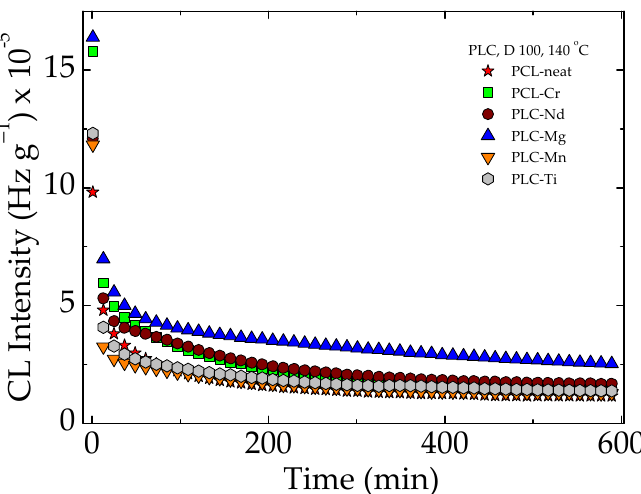
Figure 5. The isothermal CL spectra recorded on the pristine PCL-based samples containing PbZrO 3 doped with various metallic atoms after receiving a γ -dose of 100 kGy. Testing temperature: 140 °C.